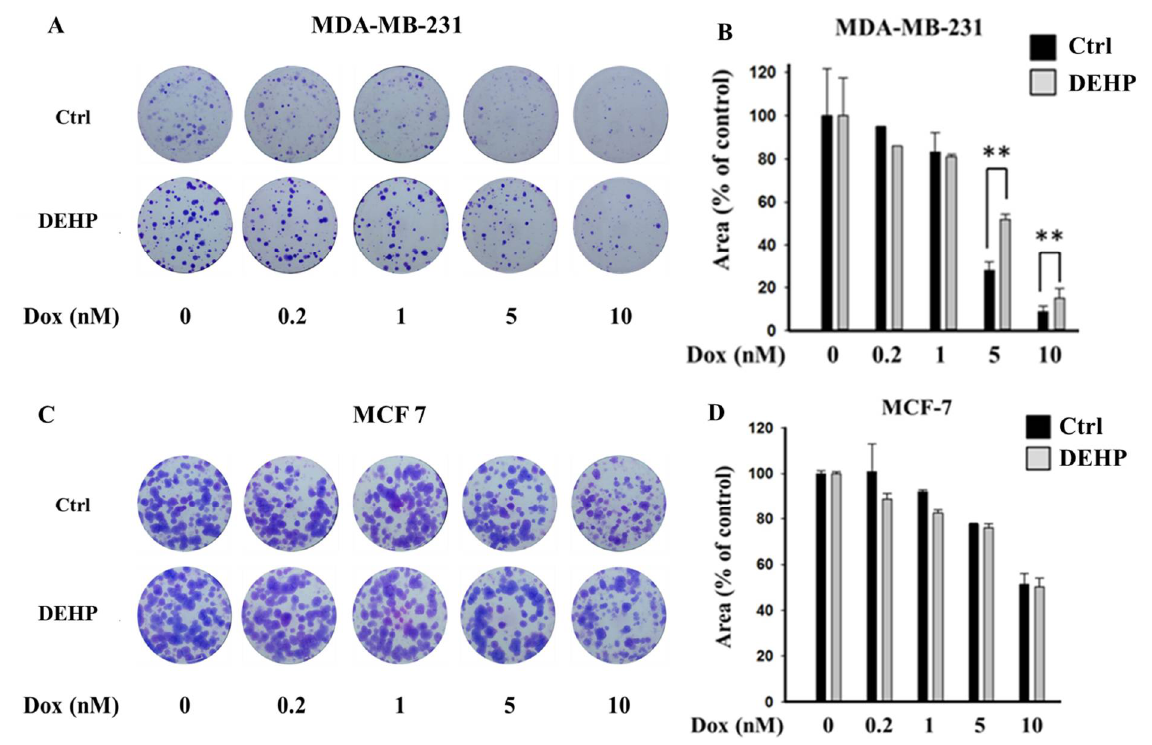
Figure 1. Representative images and quantitative analysis of cell proliferation. ( A , B ) Colony formation assay in monolayer cultures of MDA-MB-231; ( C , D ) MCF7 cells exposed to DEHP (100 nM) for 3 months and then treated with a concentration gradient of Dox (0.2, 1, 5, and 10 nM) for 72 h and grown for 10 days. ** p < 0.001.